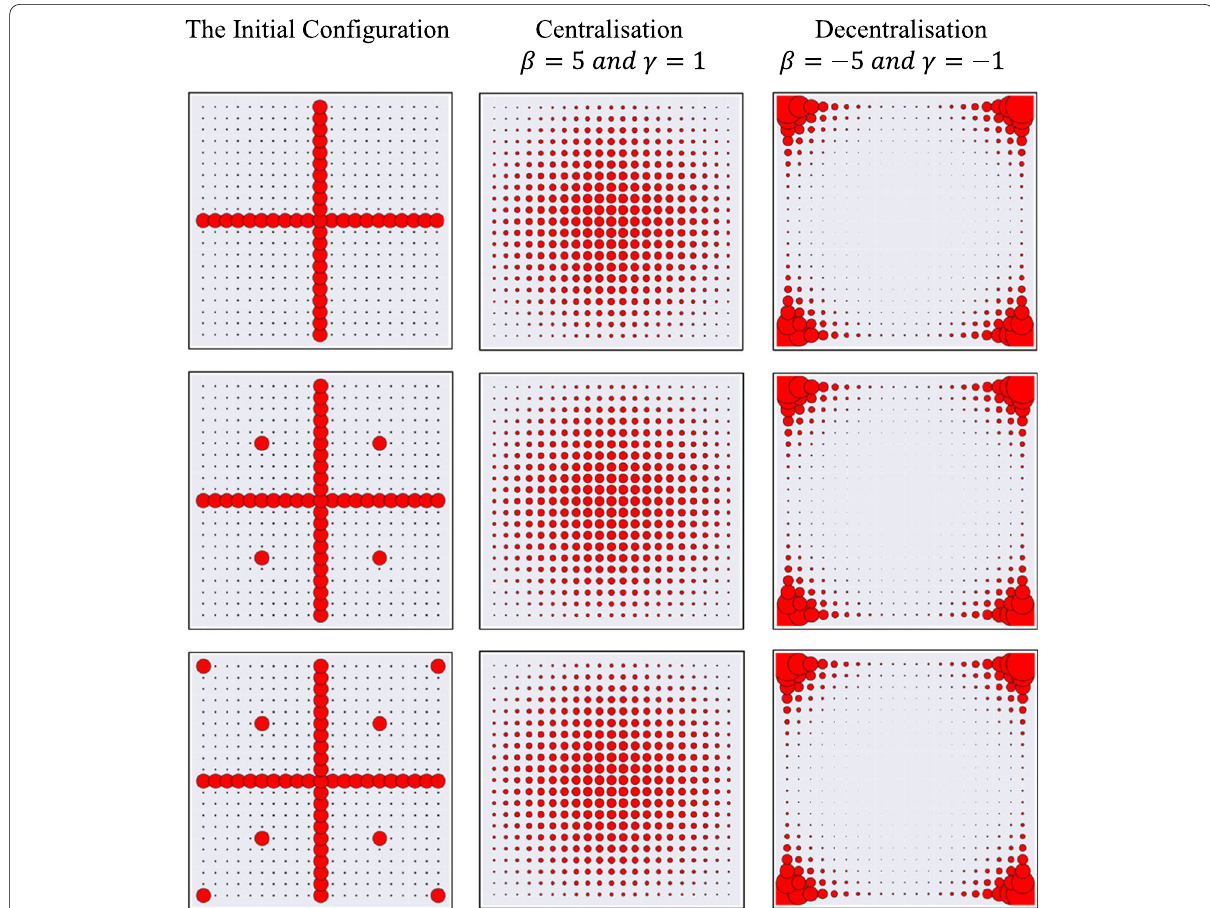
Fig. 12 Centralised & Decentralised Equilibria for Three Elaborations on the Linear